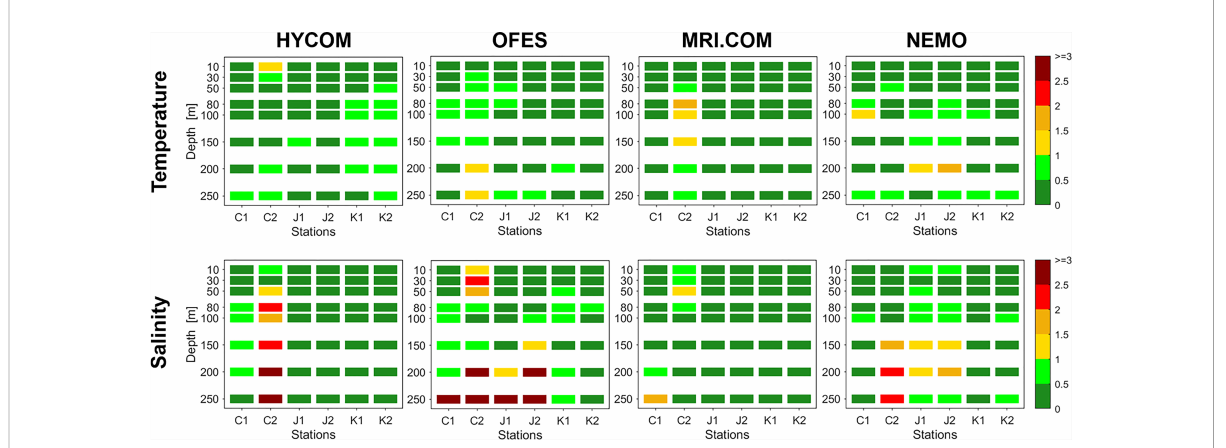
FIGURE 4 Values of Cost function derived from monthly time series of temperature (top) and salinity (bottom) from 1993 to 2014 at the six representative monitoring stations. Results from the ocean models HYCOM, OFES, MRI.COM, and NEMO (from left to right) compared with the observation data are shown at the same depths as illustrated in the Taylor diagrams in Figure 3. See text for more